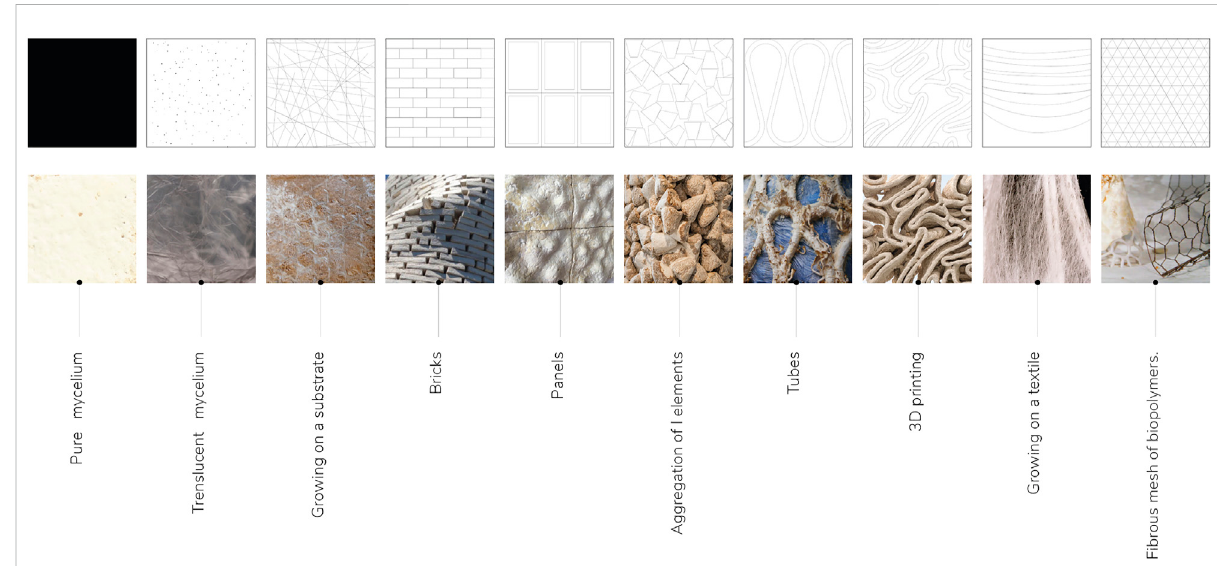
FIGURE 12 Variety of shapes and forms of mycelium-based components (growing on a substrate, panels — mogu; bricks, aggregation of elements — David Benjamin; tubes — Astudio, Aleksi Vesaluoma; 3d printing — Goidea et al., 2020, growing on textile — Jane Scott, fi brous mesh of biopolymers —